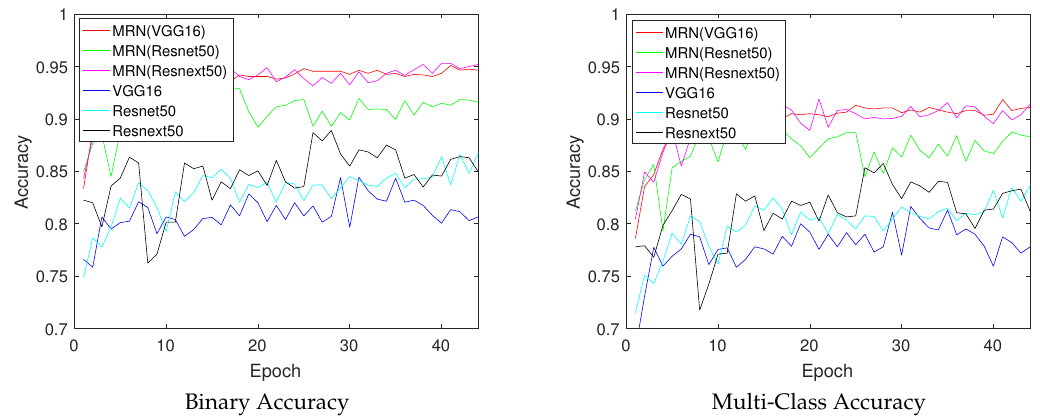
Figure 12. Accuracy evaluation according to each epoch.